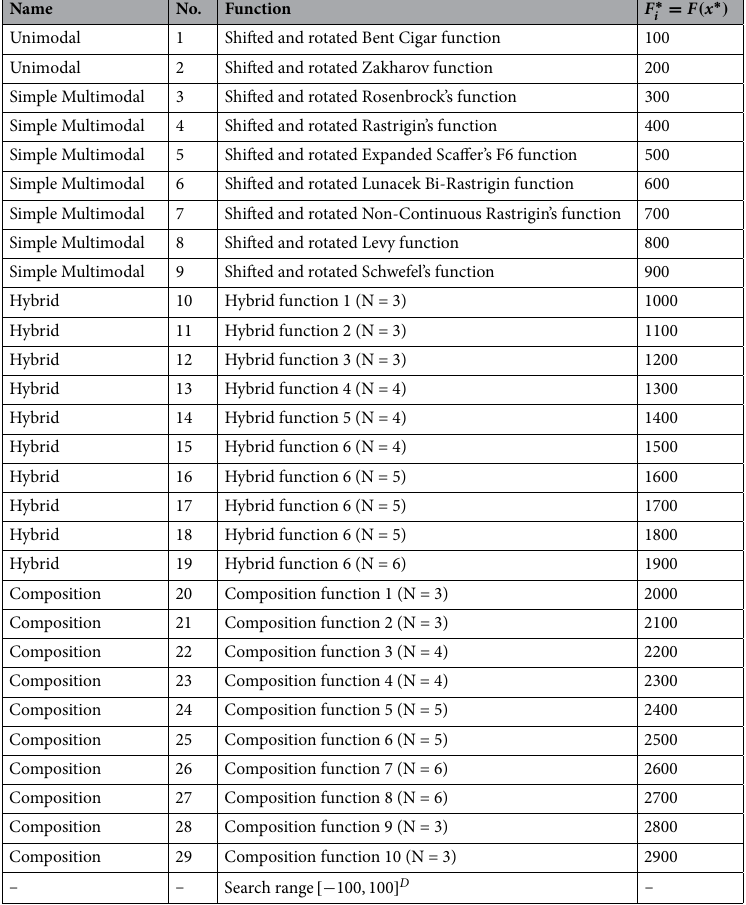
Table 1. Summary of the CEC’2017 test